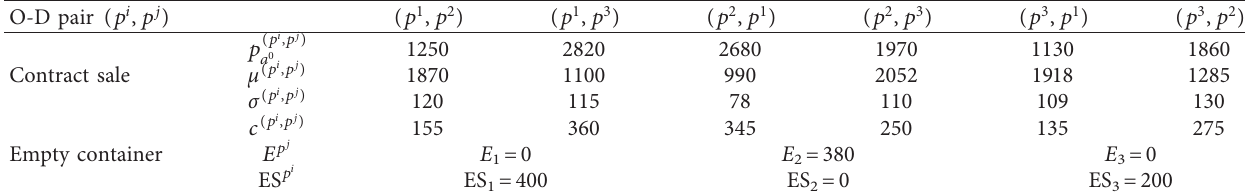
Table 1: Basis price and demand of contract sale and cost and demand of empty container transportation.